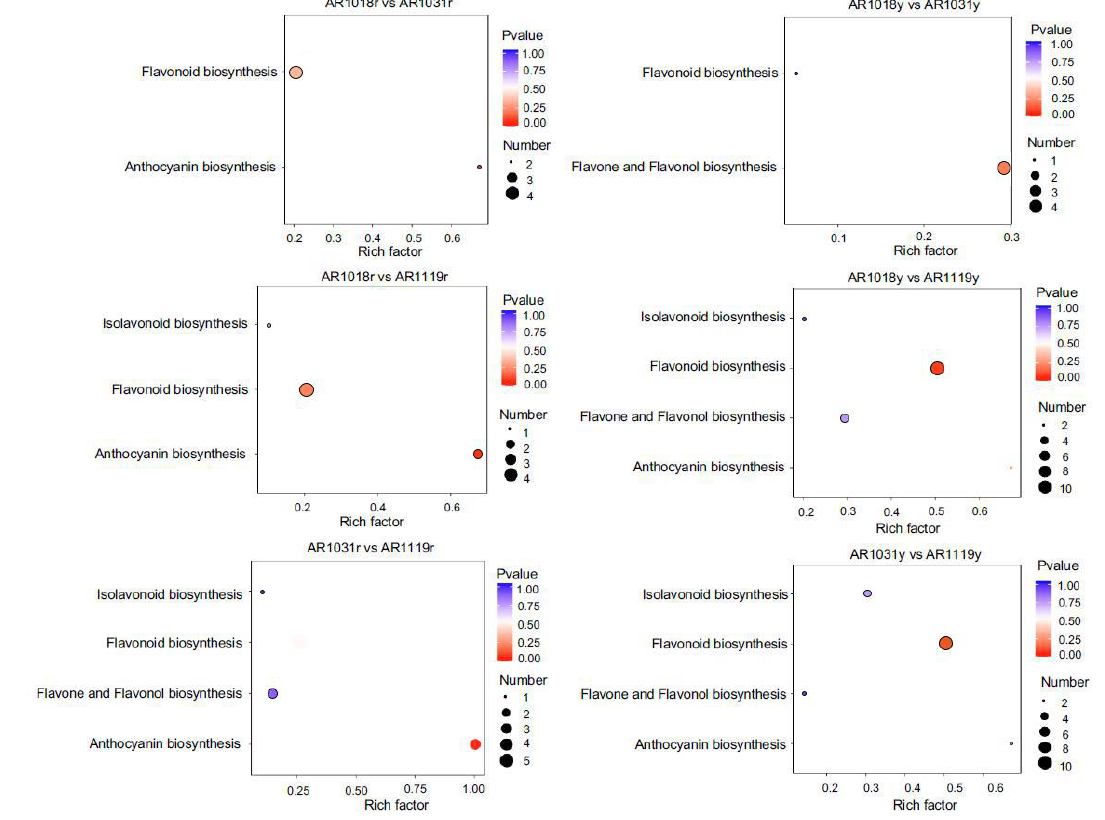
Figure 5. KEGG pathway analysis of DAMs in different groups.